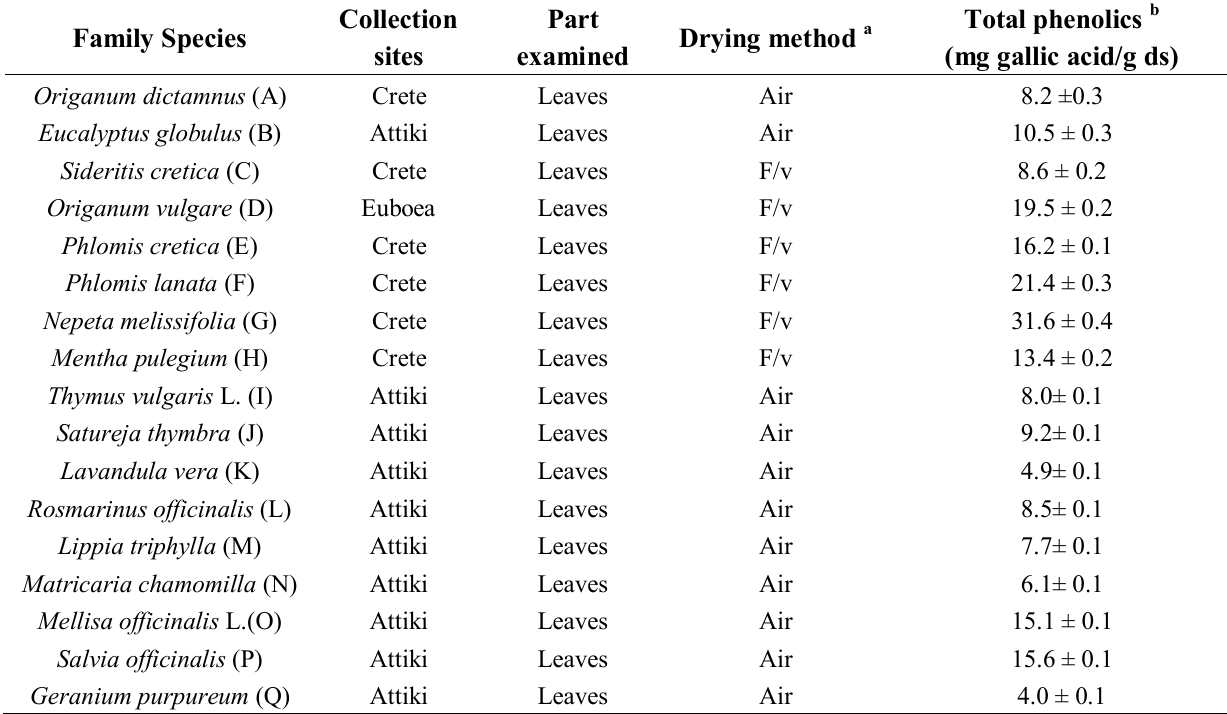
Table 1. Total phenolics in plant extracts.